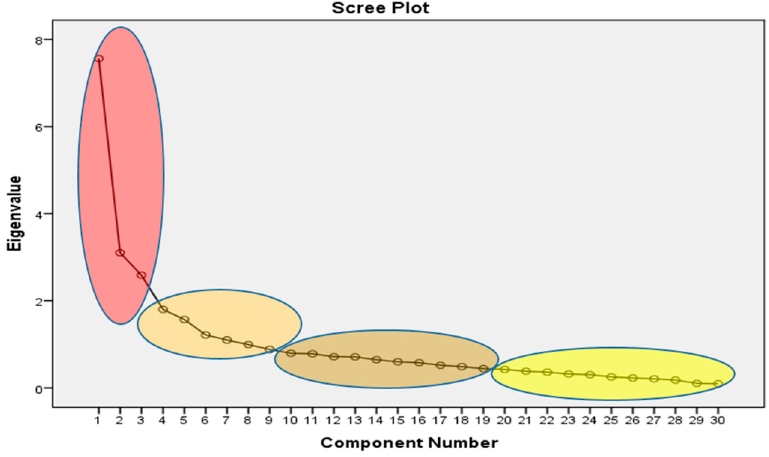
Figure 11. Scree plots of eigenvalues against factor numbers.